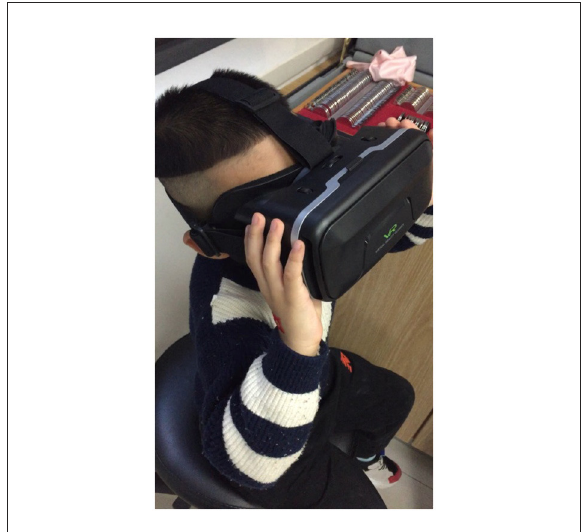
FIGURE1 Training scene of the EYEBIT system based on virtual-reality (VR) technology.